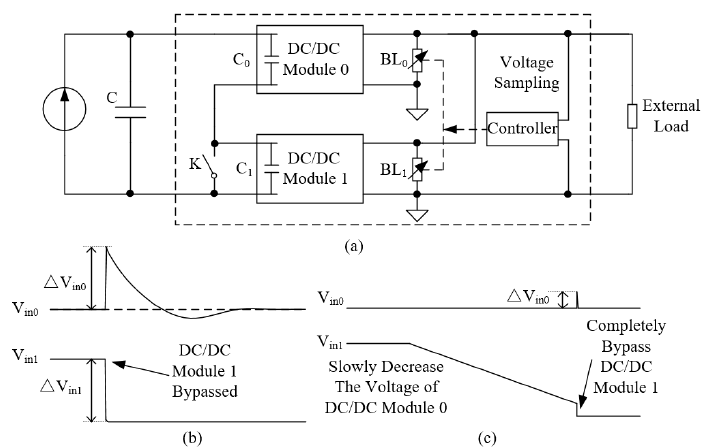
Figure 2. Illustration of potential voltage spikes in typical structures: ( a ) The equivalent diagram of a normal double-module stack structure. ( b ) The voltage spike ∆ V in0 occurs when DC / DC module 1 is directly bypassed (K is closed) and ∆ V in0 ≤ ∆ V in1 . ( c ) A soft bypass technology is studied to mainly eliminate that voltage jump during the bypass process by slowly decrease the voltage of DC / DC module 0.